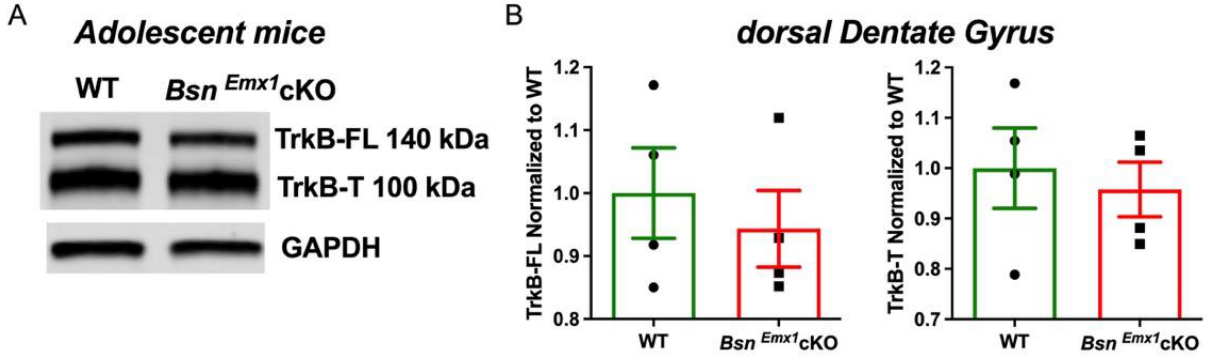
Figure 3. Unaltered TrkB levels in the dorsal DG of adolescent Bsn Emx1 cKO mice (~4–5 weeks-old). ( A ) Representative western blots of TrkB full length (FL), TrkB truncated (T) form and a loading control, GAPDH. ( B ) Quantifications of both the TrkB isoforms reveal no change in TrkB levels of adolescent Bsn Emx1 cKO ( N = 4 mice) dorsal DG compared to WT mice ( N = 4 mice). Student’s t test. All values are expressed as mean ± SEM.